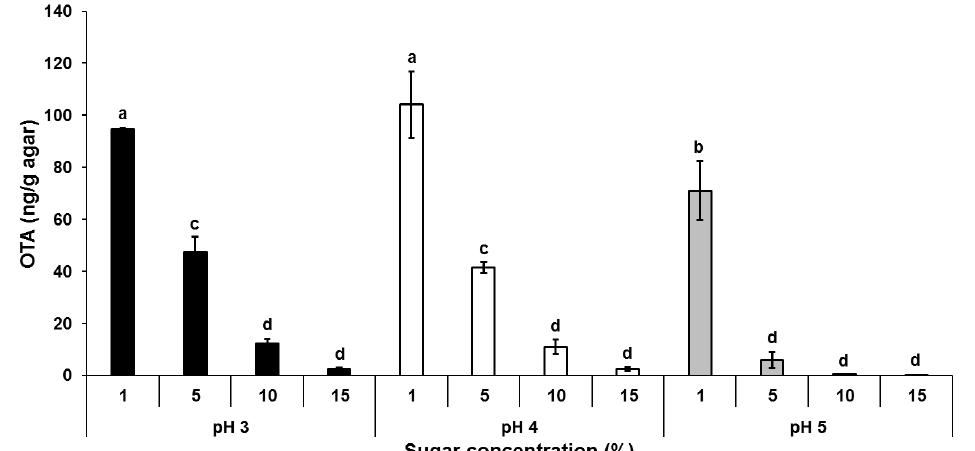
Figure 2. OTA biosynthesis is modulated by sugar and pH levels. Solid synthetic grape juice media (SGM) was supplemented with different sugar concentrations (glucose/fructose at a ratio of 2.33), and inoculated with A. carbonarius (10 6 spores/mL). OTA accumulation was evaluated at day 6 post-inoculation. Error bars represent standard error of three independent biological replicates. Different letters above the columns indicate statistically significant differences at p < 0.05, as determined using the Tukey’s honest significant difference test.